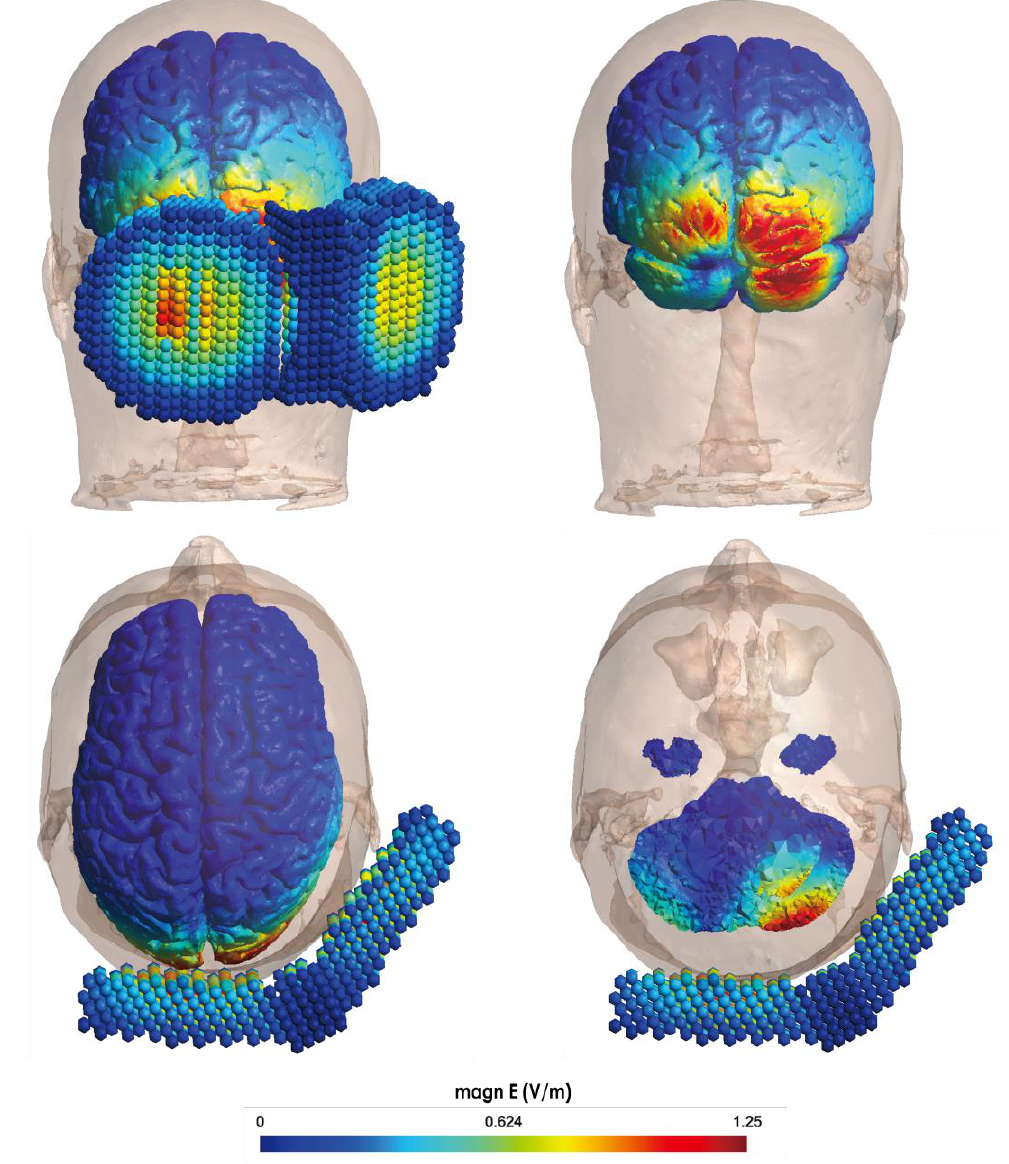
Figure 2. Visual simulation of the magnitude of the electrical fields on the right cerebellar hemisphere produced by a double-cone coil. The upper line shows images in the coronal view, and the bottom line shows images in the horizontal view. The two circular plates indicate the double-cone coil. magnE indicates the magnitude of the electrical field. The red area indicates the region with the strongest electrical field, and the blue area indicates the region of the lowest magnitude. The difference in values means that there is a difference in relative strength. These simulations display the magnitude of the electrical field that can be induced by TMS in the deep cerebellar hemispheres.